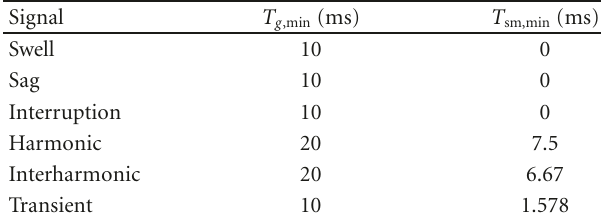
Table 2: Limit of the kernel parameters.